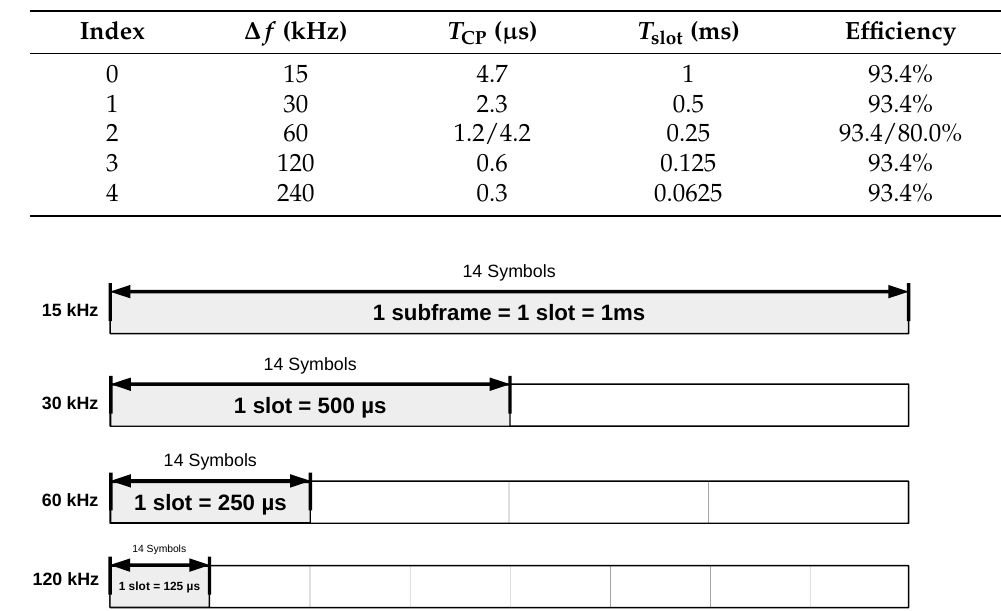
Figure 1. 5G new radio (NR) frame